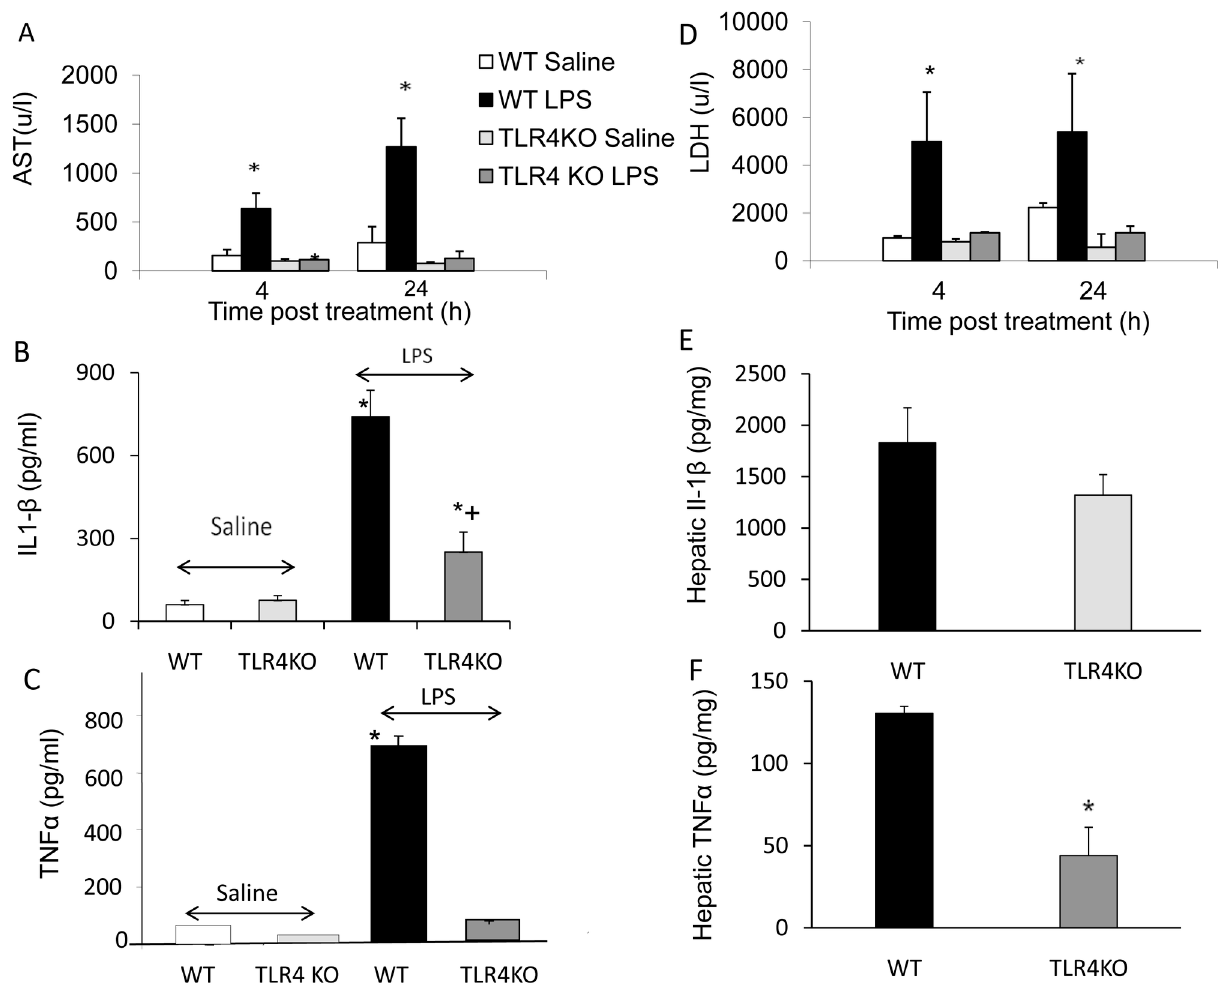
Figure 2. Serum biochemical analysis. Figs. A, D.: The serum LDH and AST level increased significantly in LPS-administered WT mice compared with saline administered mice. In LPS administered TLR4KO, the increase in serum enzyme levels was much lower compared with saline administered and compared with LPS administered WT mice (4 and 24 hours). Values are mean±SEM with n=6 mice per group *p<0.01 compared with other groups. Figs. B, E: The serum and hepatic Il-1β level increased significantly in WT mice following LPS compared with saline treated mice (p< 0.01). TLR4KO mice hepatic IL-1β level was significantly lower compared with WT LPS treated mice (p< 0.05). Values are mean±SEM (n=6 mice per group). Figs. C, F: The serum and hepatic TNFα level increased significantly in LPS WT-treated mice (p< 0.01). In TLR4KO mice the hepatic TNFα level was significantly lower compared with WT LPS treated mice (p< 0.005) and serum TNFα rose by a very small amount. Values are mean±SEM (n=6 mice per group). doi: 10.1371/journal.pone.0073041.g002 values. The control (non-treated) cells were assigned a value survival. Differences were analyzed by the log-rank sum test. of 1. Results were normalized to control levels [18,19].